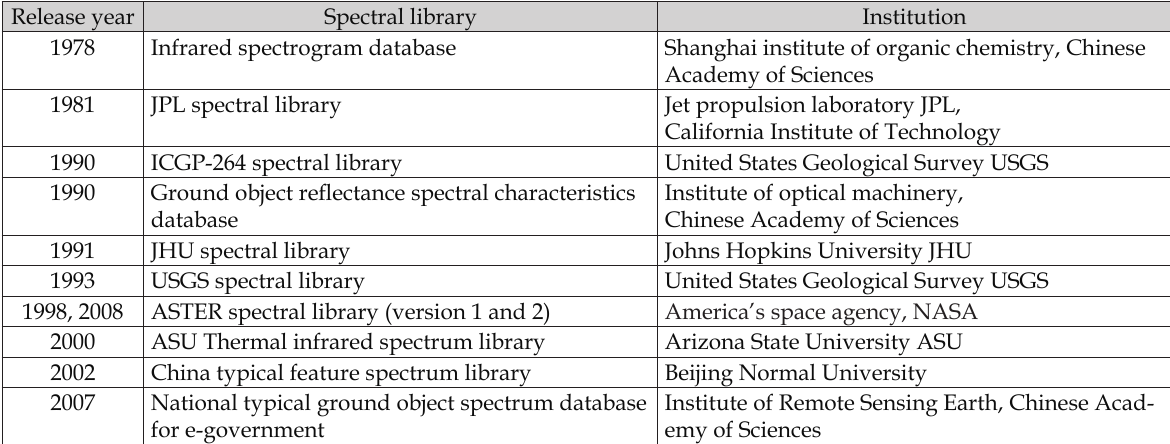
Table 1. A selection of current widely available spectral libraries (based on Xie et al. 2020,